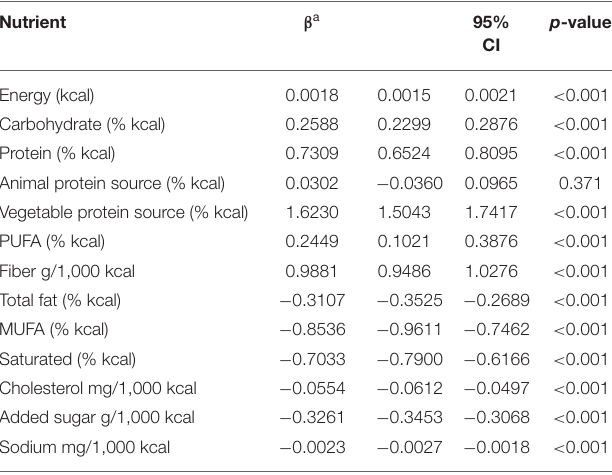
TABLE 2 | Association between Cardiovascular Health Diet Index score and selected nutrients. ELSA-Brasil,